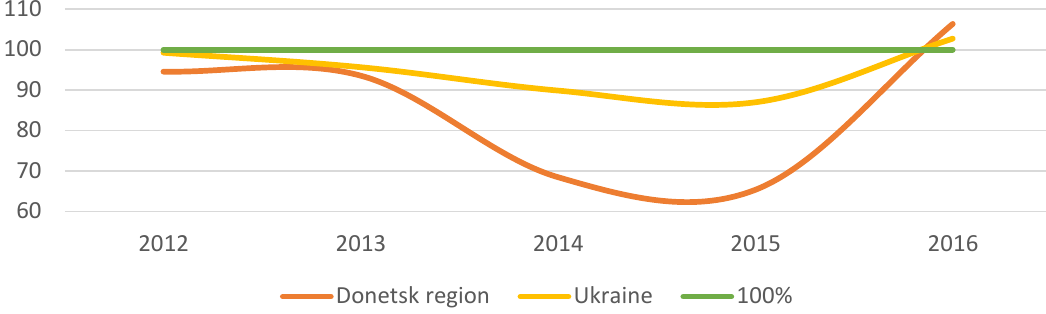
Figure 1. Dynamics of indices of industrial production for